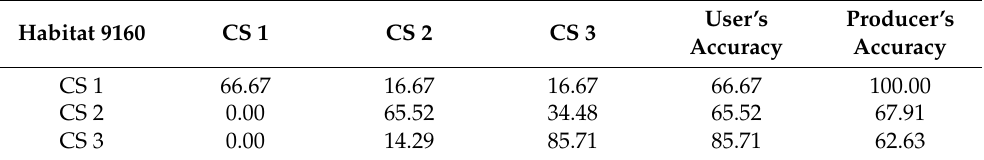
Table 7. Confusion matrix for the most accurate classification model using ALS data after validation for habitats 9160. Values are shown in %. CS stands for conservation status. Additionally, 9160 is Quercus robur habitat, 9230 is Quercus pyrenaica habitat, and 9240 is Quercus faginea habitat.